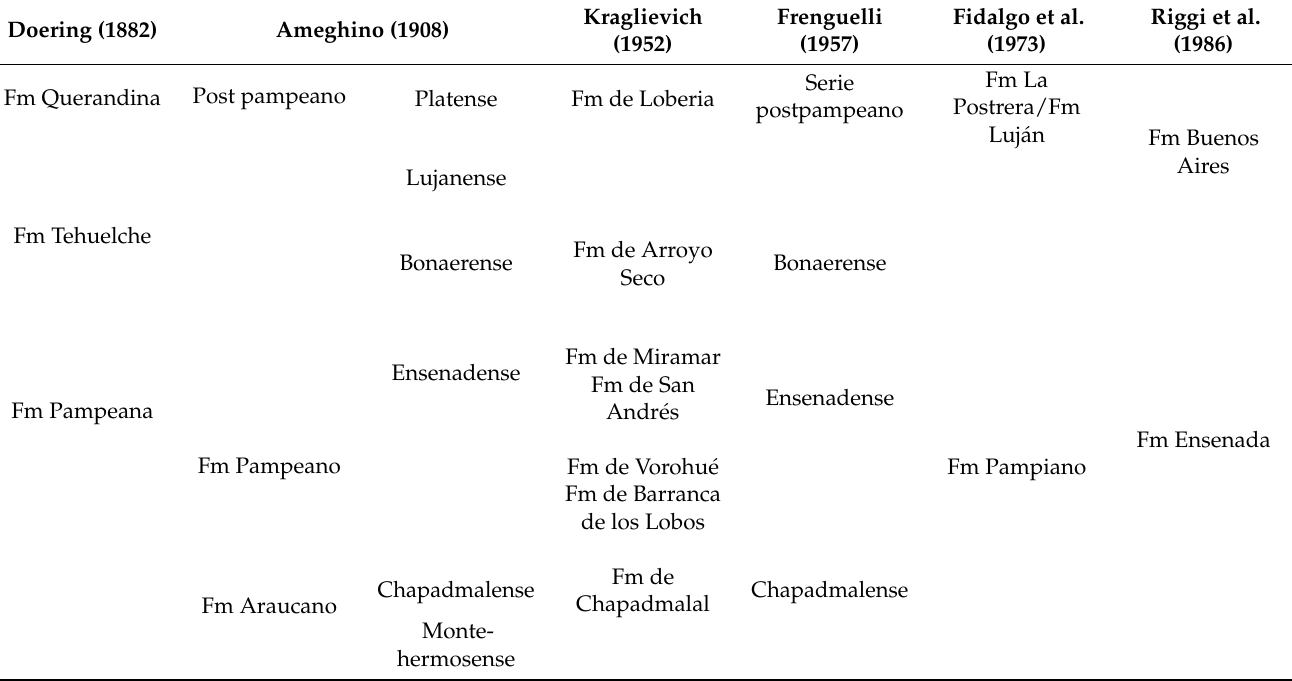
Table 1. The main stratigraphic schemes proposed for the Pampean